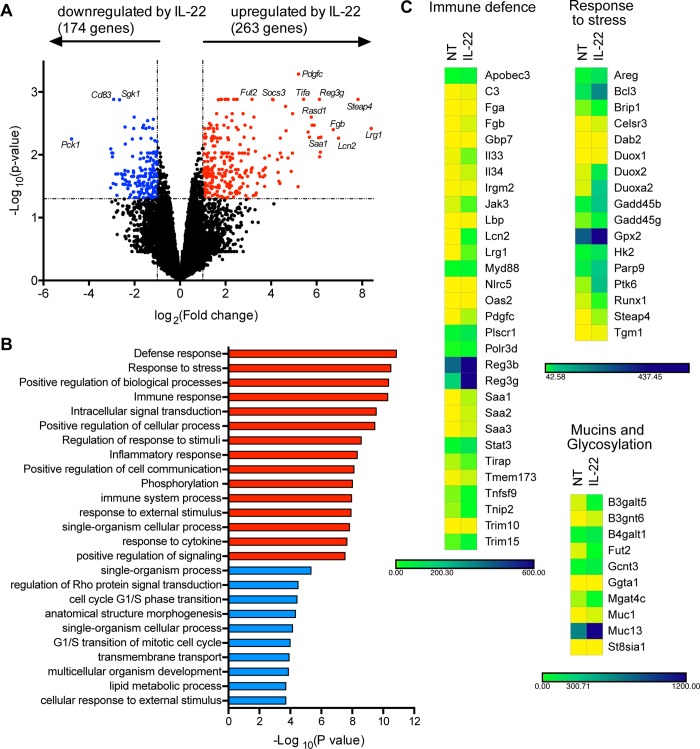
IL-22 regulates genes involved in intestinal immune defence responses.WT organoids were treated with IL-22 (2 ng/ml) for 3 hours. RNA was isolated for RNAseq analysis. (A) Volcano plot showing fold change (log2) in gene expression of WT organoids treated with IL-22 (2 ng/ml) for 3 hours compared to untreated WT organoids, plotted against significance (−log10[p-value]). Red = significantly up-regulated gene (fold change > 2, p < 0.05), blue = significantly down-regulated genes (fold change < 0.5, p < 0.05). (B) Functional enrichment analysis (GO term: “Biological processes”) for genes up- or down-regulated in WT organoids treated with IL-22, compared to untreated WT organoids. Shown are the top 15 up-regulated (red) and 10 down-regulated pathways (blue). (C) Heatmaps displaying mRNA expression level of significantly regulated genes in WT organoids either not treated or treated with IL-22. Genes of interest were manually grouped by their main biological function. Numerical values for panel B are available in S1 Data and for panels A and C in S2 Table. GO, gene ontology; IL-22, interleukin-22; NT, not treated; RNAseq, RNA sequencing; WT, wild-type.